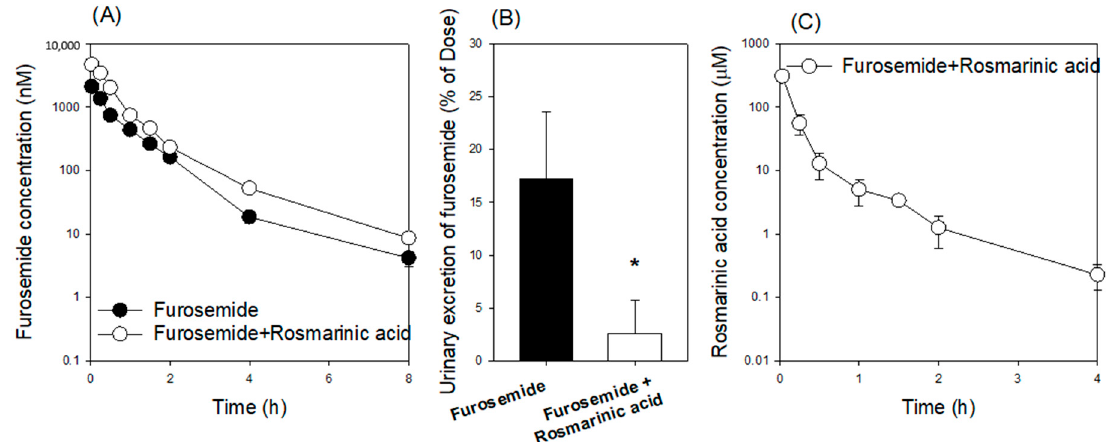
Figure 6. ( A ) The plasma concentration-time profile and ( B ) urinary excretion of furosemide following the intravenous injection of furosemide (0.2 mg/kg) in the absence ( • ) or presence ( ) of rosmarinic acid (10 mg/kg). ( C ) The plasma (cid:35) concentration-time profile of rosmarinic acid following the intravenous injection of furosemide (0.2 mg/kg) and rosmarinic acid (10 mg/kg). Each data point represents the mean ± standard deviation ( n = 4). * p < 0.05 compared with furosemide group. Table 3. Pharmacokinetic parameters of furosemide and rosmarinic acid in rats. Furosemide Rosmarinic Parameters